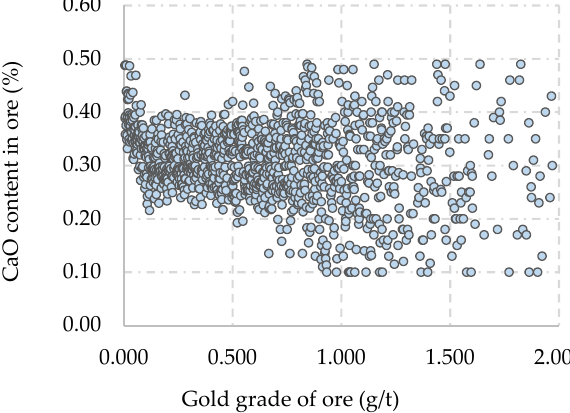
Figure 10. Scatterplot of CaO versus gold grade.